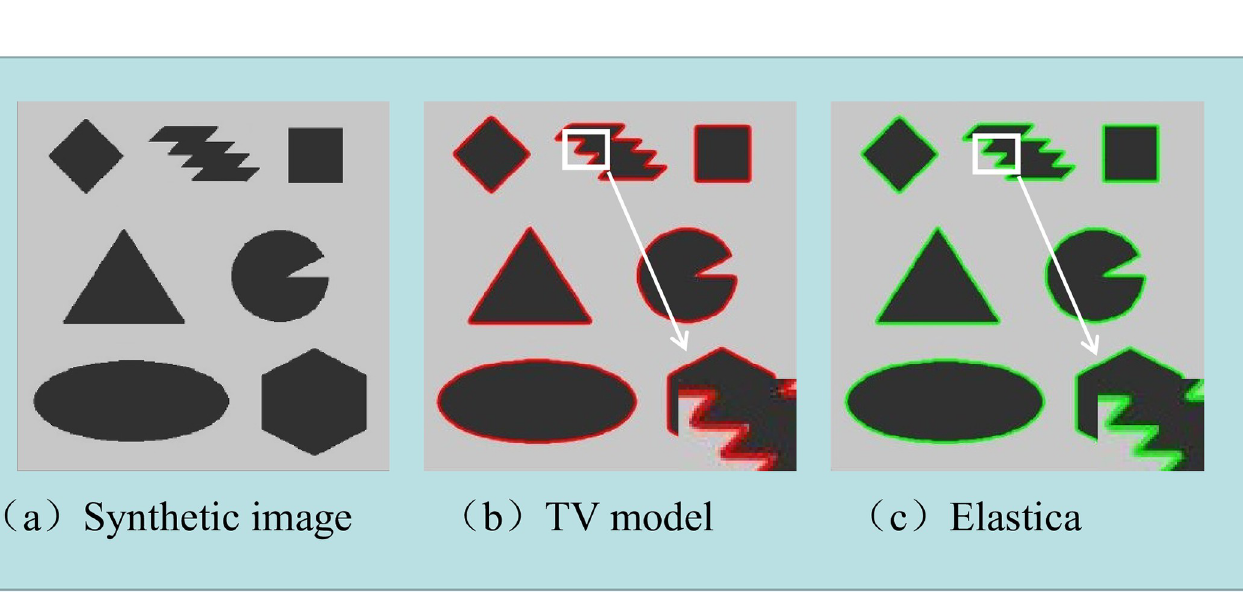
PLOS ONE | https://doi.org/10.1371/journal.pone.0261195 March 15,